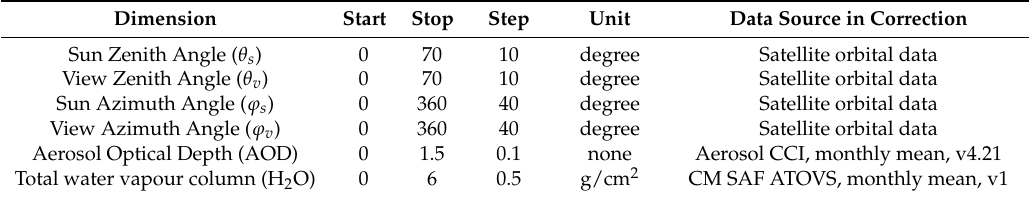
Table 1. The dimensions and resolution for the 6S atmospheric correction